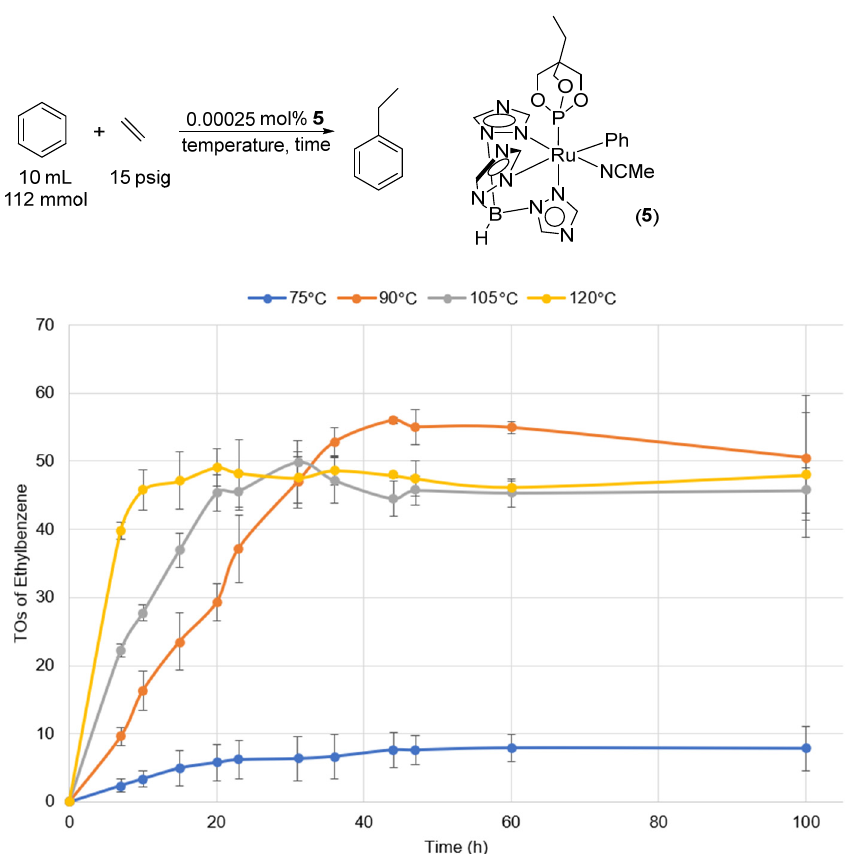
Figure 3. Ethylene hydrophenylation catalyzed by (Ttz)Ru(P(OCH 2 ) 3 CEt)(NCMe)Ph ( 5 ) at different temperatures. Conditions: 10 mL benzene solution of 0.00025 mol% complex 5 , 15 psig ethylene; 75, 90, 105, and 120 °C. Error bars represent standard deviations from at least three independent experiments.